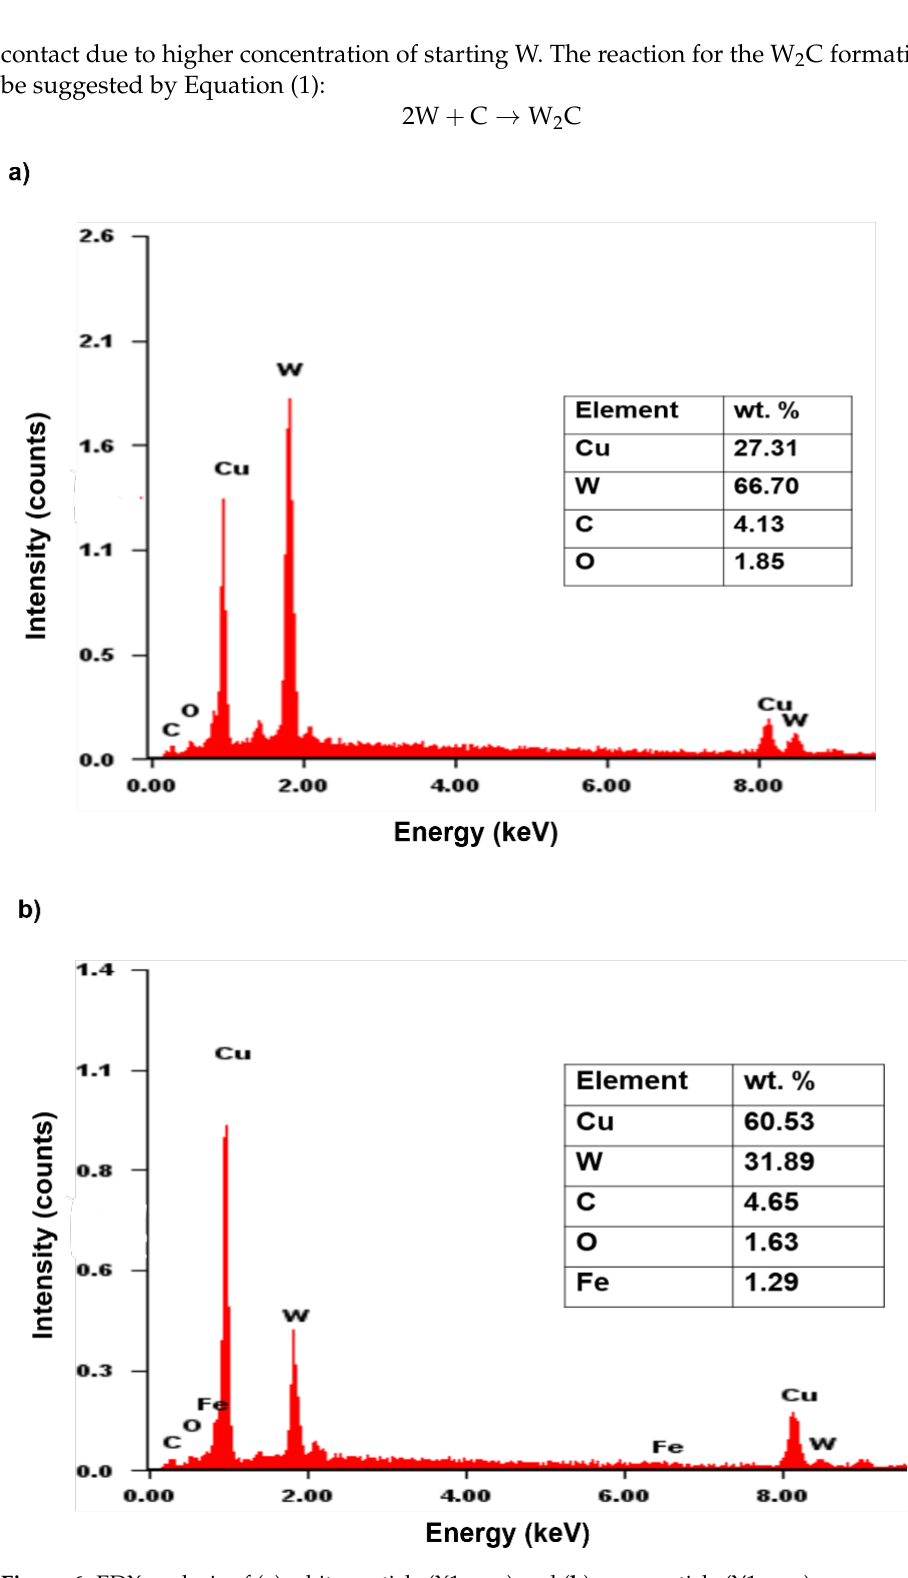
Figure 6. EDX analysis of ( a ) white particle (X1 area) and ( b ) grey particle (Y1 area) corresponding to Figure 5a,c, respectively.